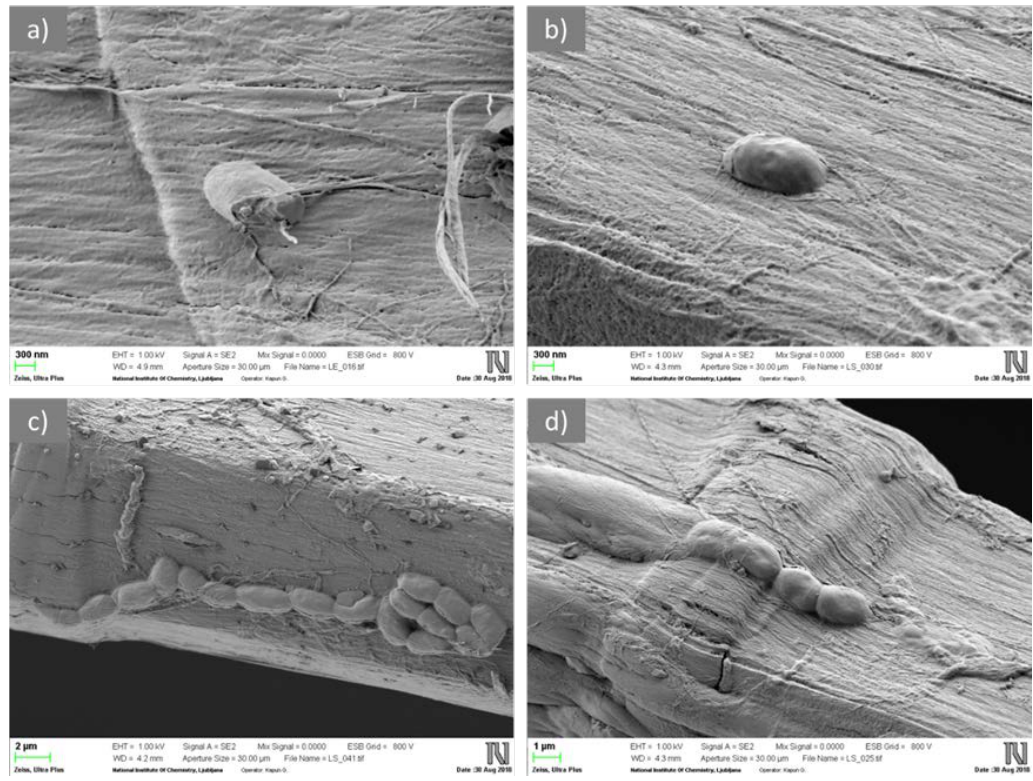
Figure 5. SEM images of E. coli ( a ) and S. aureus ( b – d ) on the surface of LI fibers.